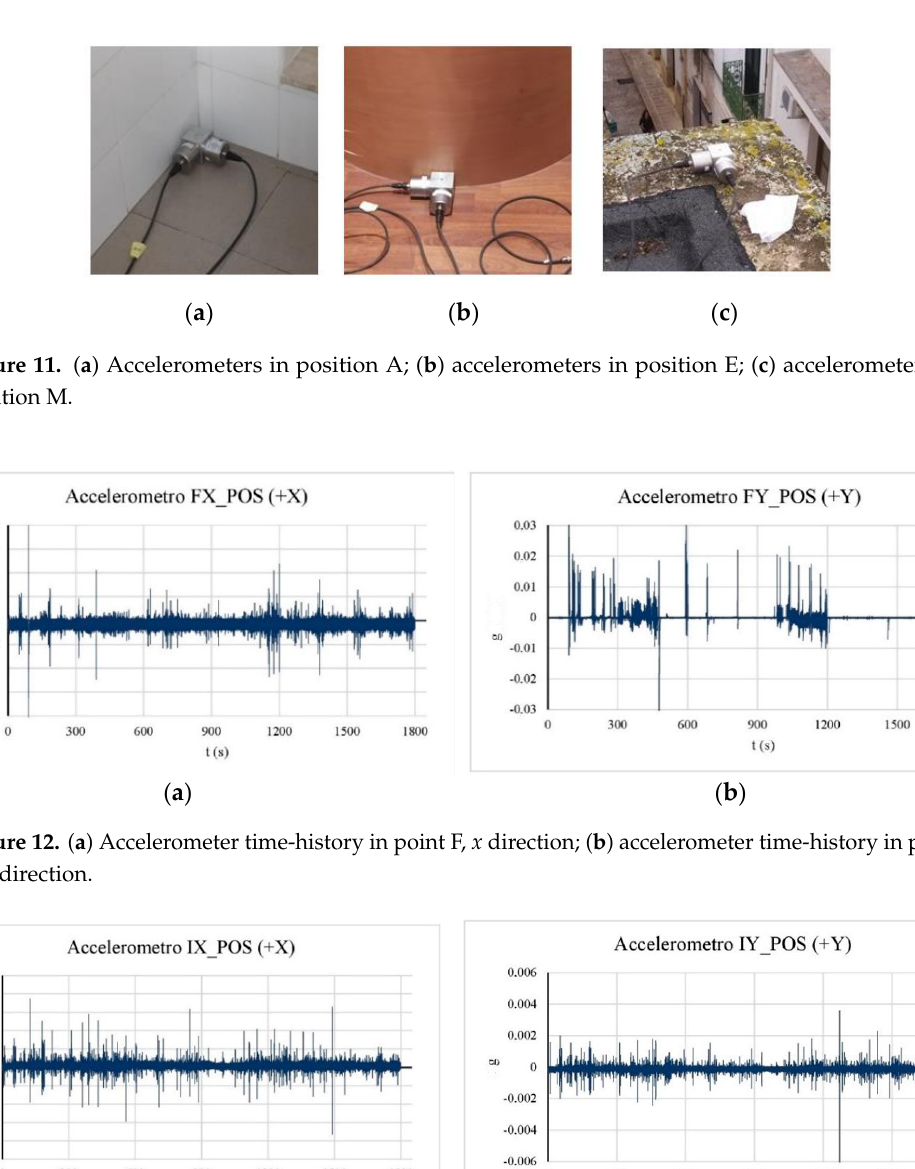
Figure 12. ( a ) Accelerometer time-history in point F, x direction; ( b ) accelerometer time-history in point F, y direction.